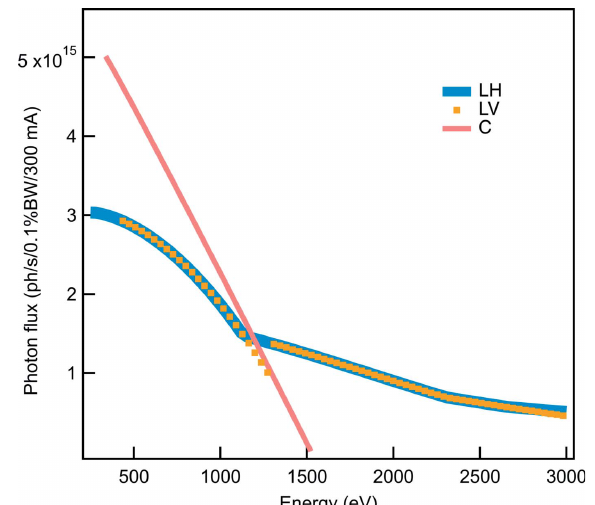
Figure 6 Simulated photon flux transmitted through the I21 front-end as a function of energy for three polarizations: linear horizontal (LH), linear vertical (LV) and circular (C). The simulation was done for the existing front-end aperture, which has an angular acceptance of 178 m rad horizontally and 143 m rad vertically. This allows >99% of the beam to pass through at the minimum energy of 250 eV. Circularly polarized light is available up to 1500 eV using the first harmonic. For linearly polarized light, the highest flux is provided by the first harmonic up to around 1200 eV, while the third harmonic provides the highest flux up to 2300 eV. Higher harmonics (up to the 11th harmonic) provide the maximum flux for linearly polarized light up to 3000 eV.